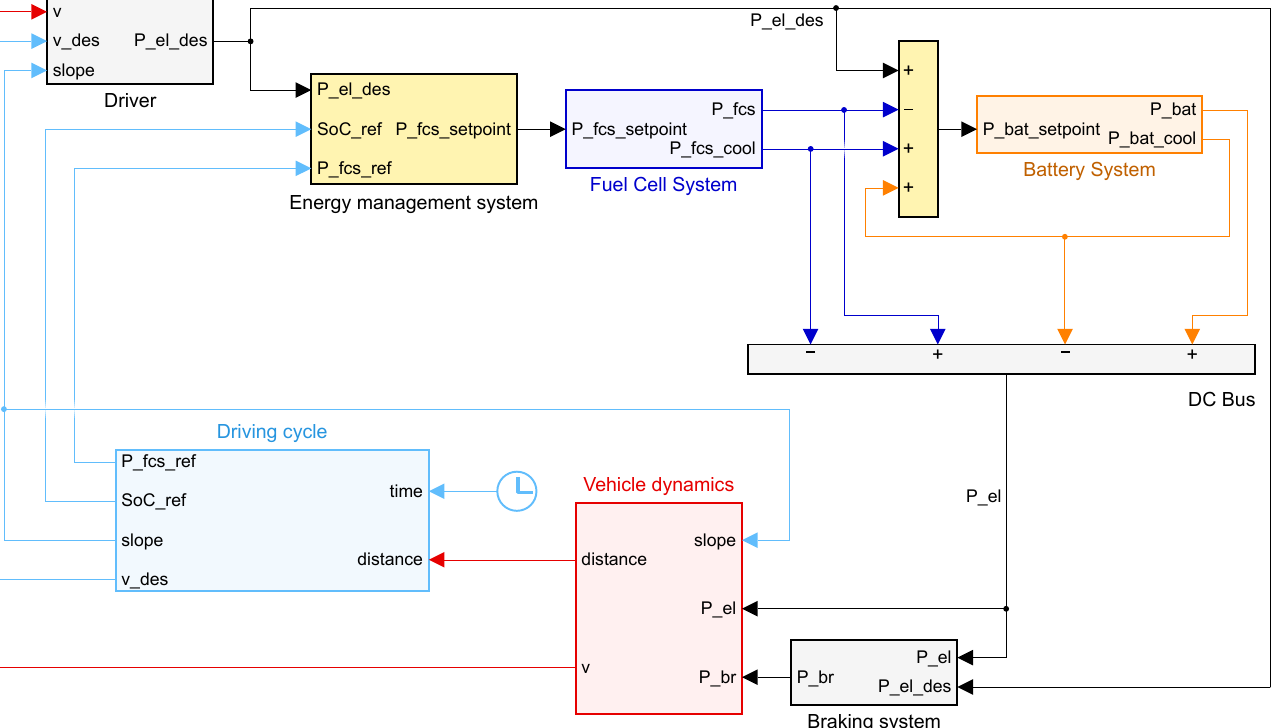
Figure 1. Overview of the fuel cell vehicle model in MATLAB/Simulink. For readability, some signals are hidden and exchanged directly between